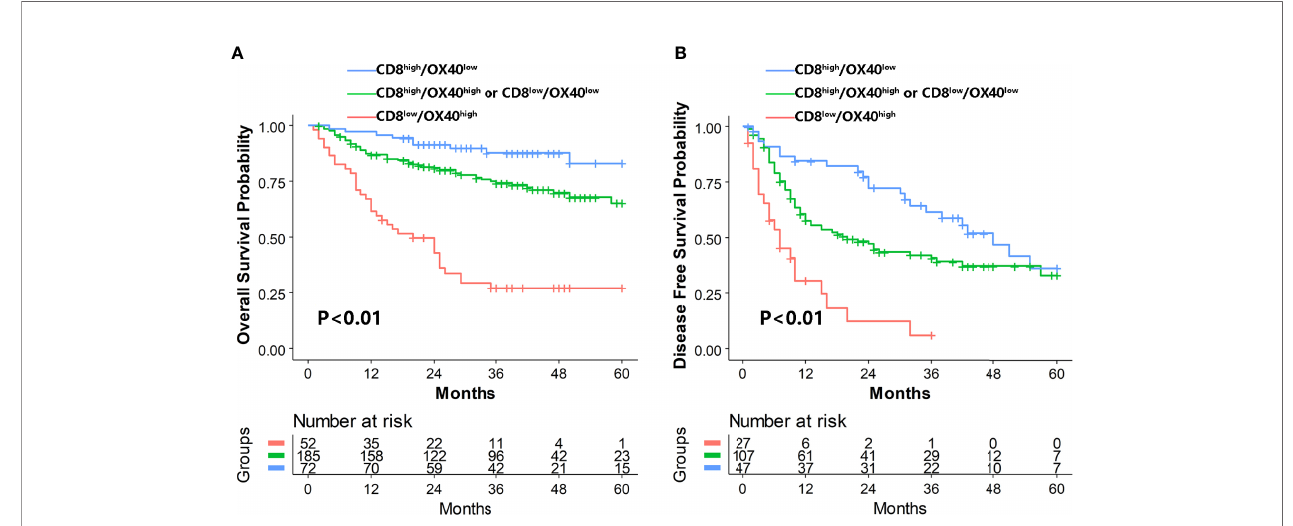
FIGURE 3 | Kaplan – Meier analysis of OS (A) and DFS (B) for CD8+/OX40+ TIL ratio. OS, overall survival; DFS, disease-free survival; TILs, tumor-in fi ltrating lymphocytes.